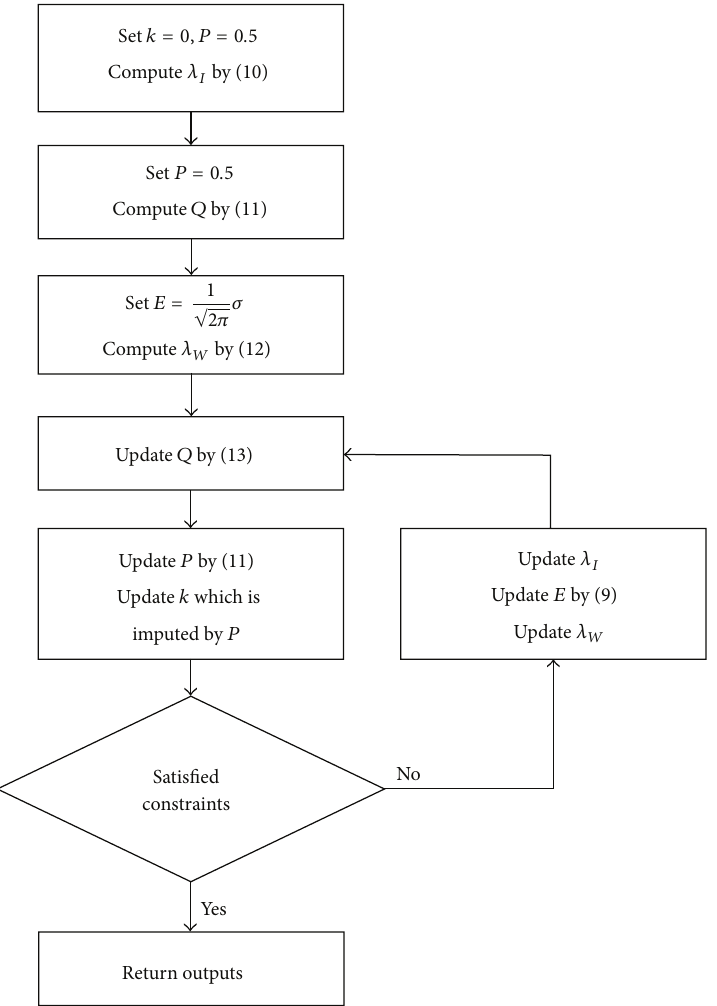
Figure 2: Flow chart of the search